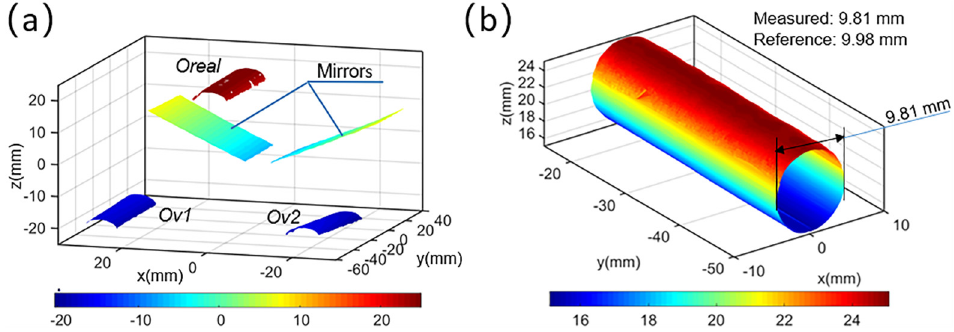
Figure 6. ( a ) Reconstructed shapes of the two planar mirrors and the cylinder object; ( b ) 360-deg full surface of the cylinder obtained with reflection transformation performed on virtual surfaces.